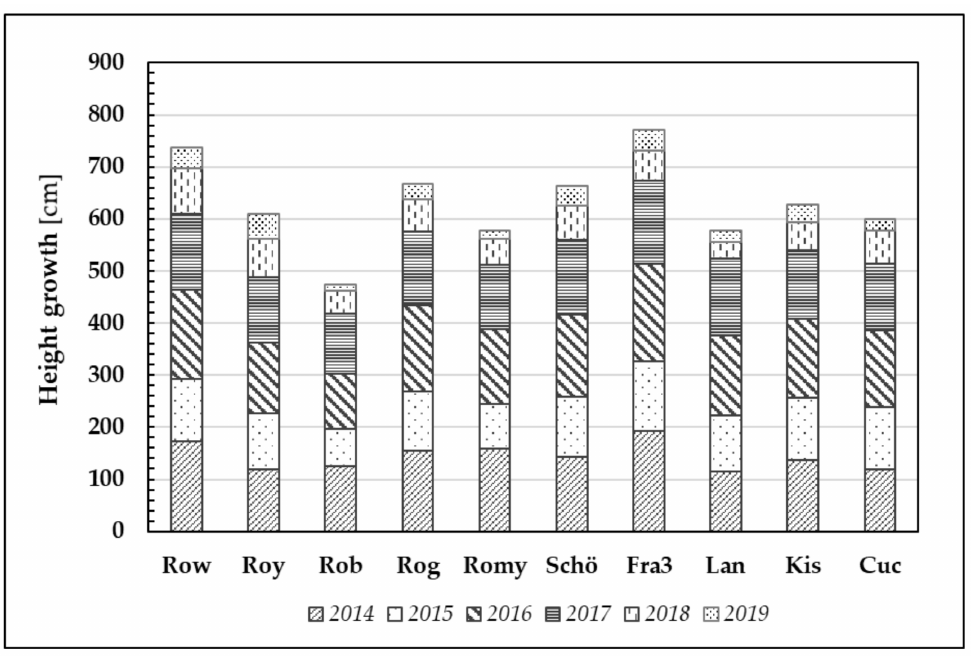
Figure 7. Plant height growth through the years 2014–2019 of ten Robinia test units. Note that one bar usually comprised 20 Robinia test trees per origin and per